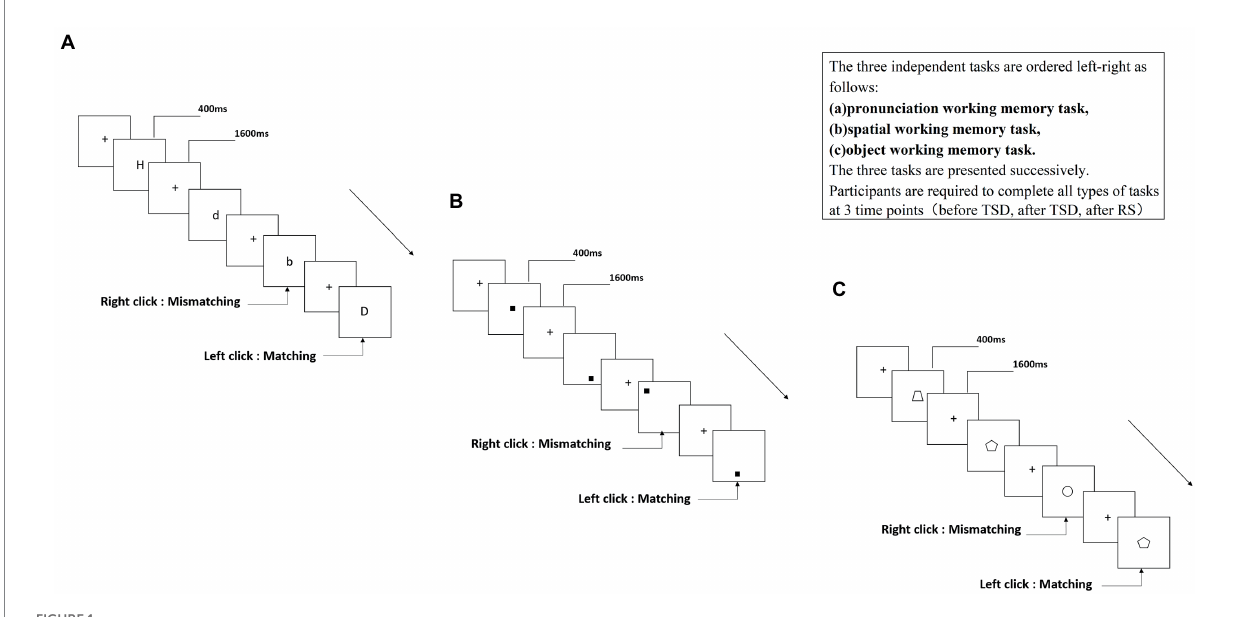
FIGURE 1 Schematic diagram of the working memory